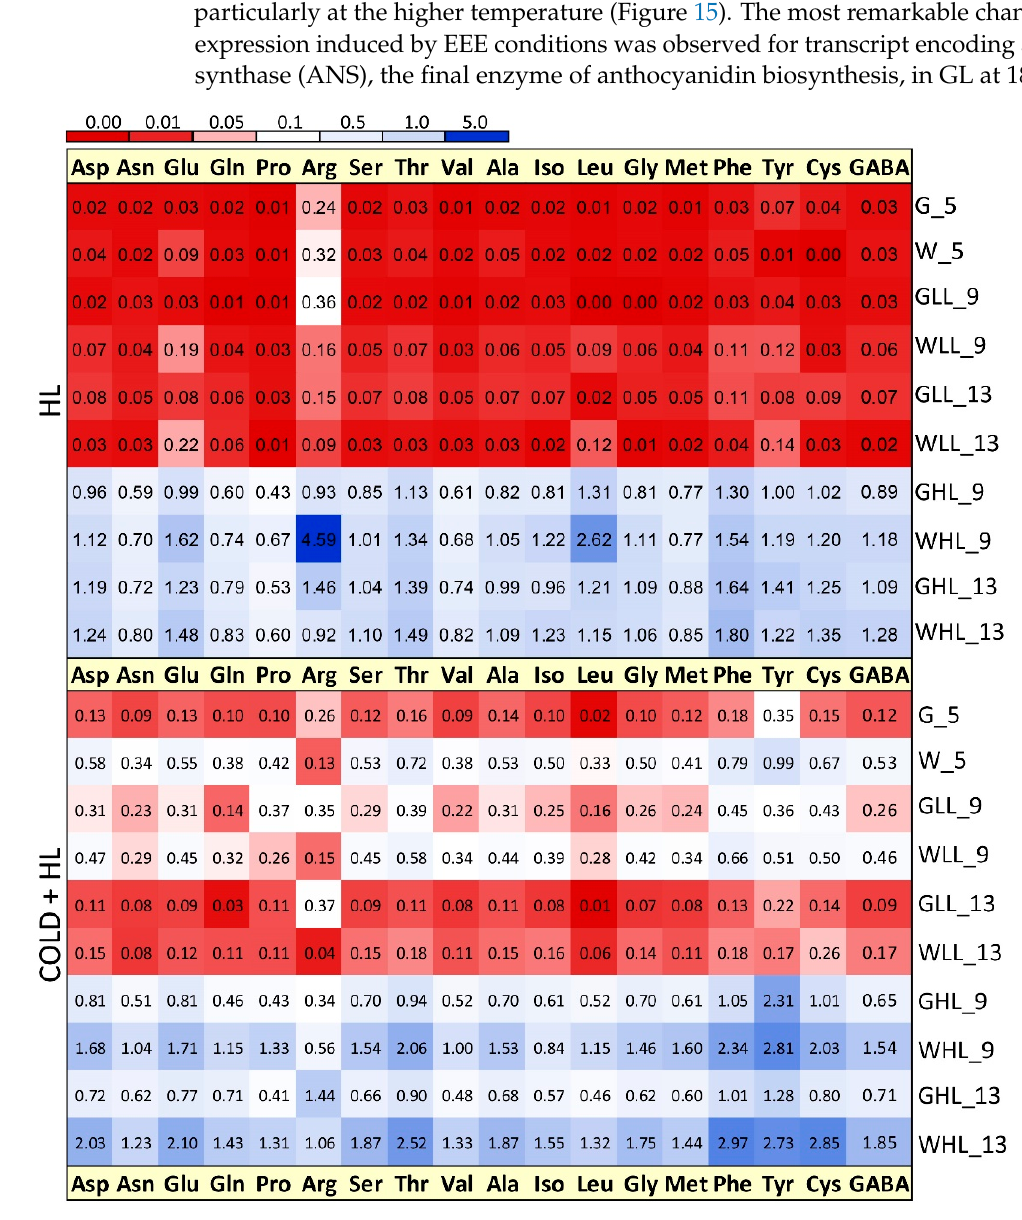
Figure 14. Distribution (%) of 15 N free amino acids in GL and WL of P. zonale plants under optimal ( HL ) and lower temperatures ( Cold + HL ). The experimental conditions are explained in the legend to Figure 5. SE for each value was 2.1–19.7%; n = 4–5 and 1.1–17.9%; n = 3–7 in the HL and Cold + HL experiments, respectively.